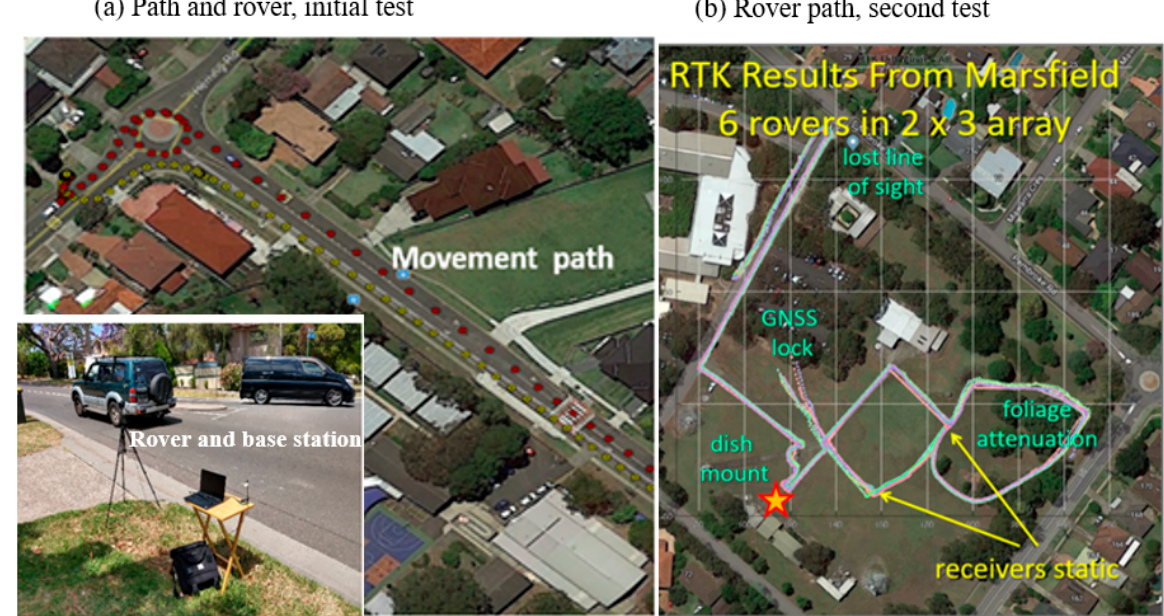
Figure 3. The areas where the accuracy performance of the device was first tested including ( a ) the initial test with the rover driven in a car (movement track indicated by the red dotted line), and ( b ) the second test with 6 rovers carried by experimenters (movement tracks indicated by coloured lines) where ‘GNSS lock’ indicates the starting position and the star indicates the position of the base station. Note: The multiple lines indicating 6 tracks can be seen during the initial GNSS lock up as well as in the “foliage attenuation” area, but the accuracy of the results negates clear visual separation of the 6 tracks during optimal operation.